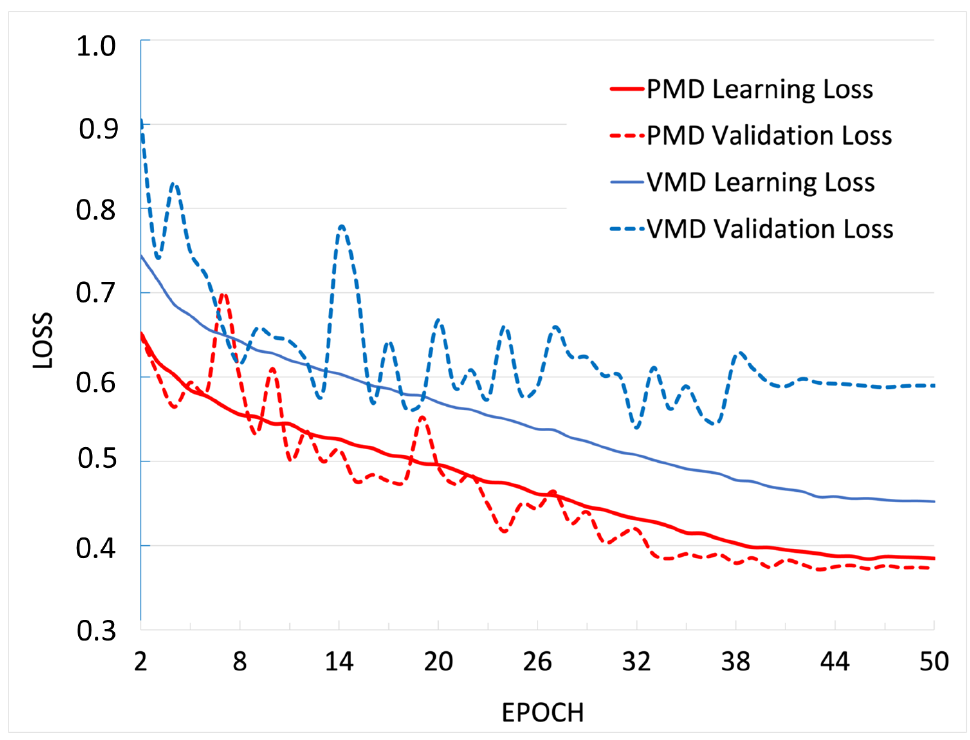
Figure 8. Process of learning and validation of the models through epochs (PMD – Pest Monitoring Device, VMD – Vegetation Monitoring Device).